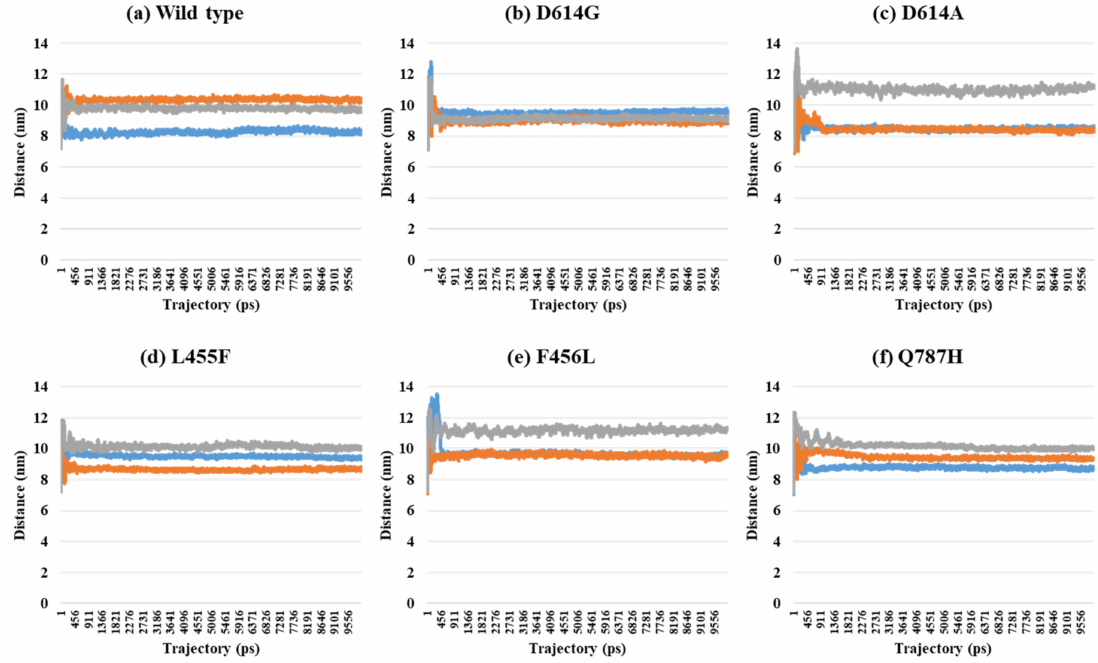
Figure 4. Distance between V503 residues in two chains depending on MD trajectories in the 3-open-complex form (7A98). ( a ) Wild type, ( b ) D614G, ( c ) D614A, ( d ) L455F, ( e ) F456L, and ( f ) Q787H. The X axis denotes trajectory (ps), and the Y axis denotes distance (nm). Blue color indicates the distance between A and B, orange indicates A–C distance, and gray indicates distance between B and